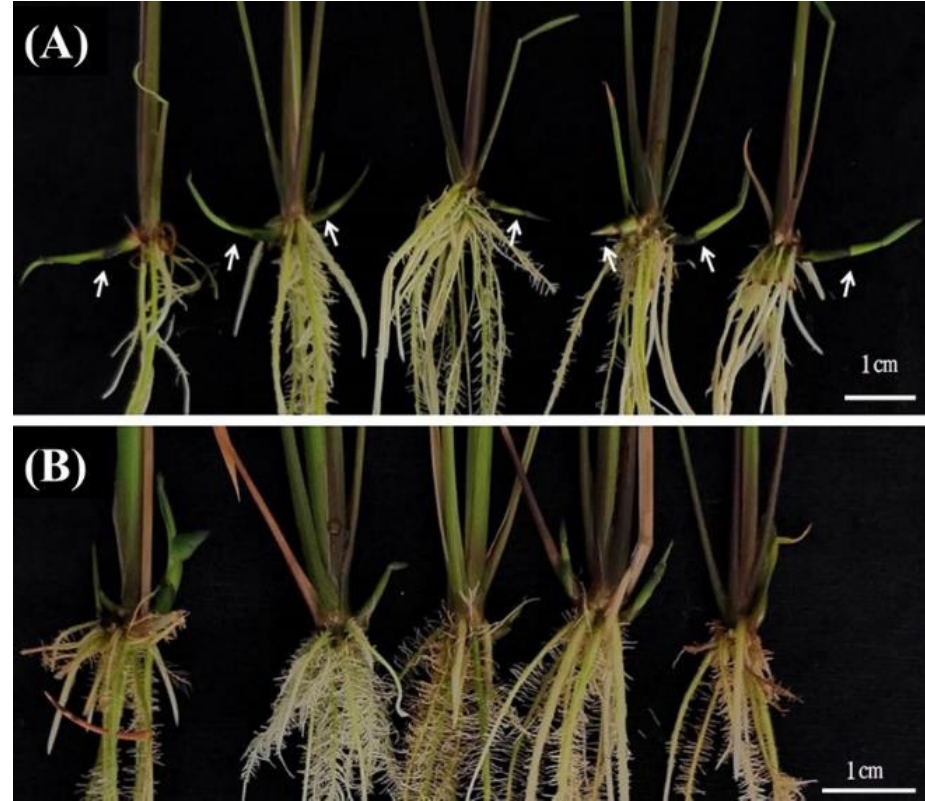
Figure 2. Branch formation in mediums with different sucrose concentrations and additional uni-conazole. The working concentration of uniconazole is 0.2 mg/L. The sucrose concentration in ( A ) is 100 g/L, and that in ( B ) is 20 g/L. Arrows indicate rhizomes.